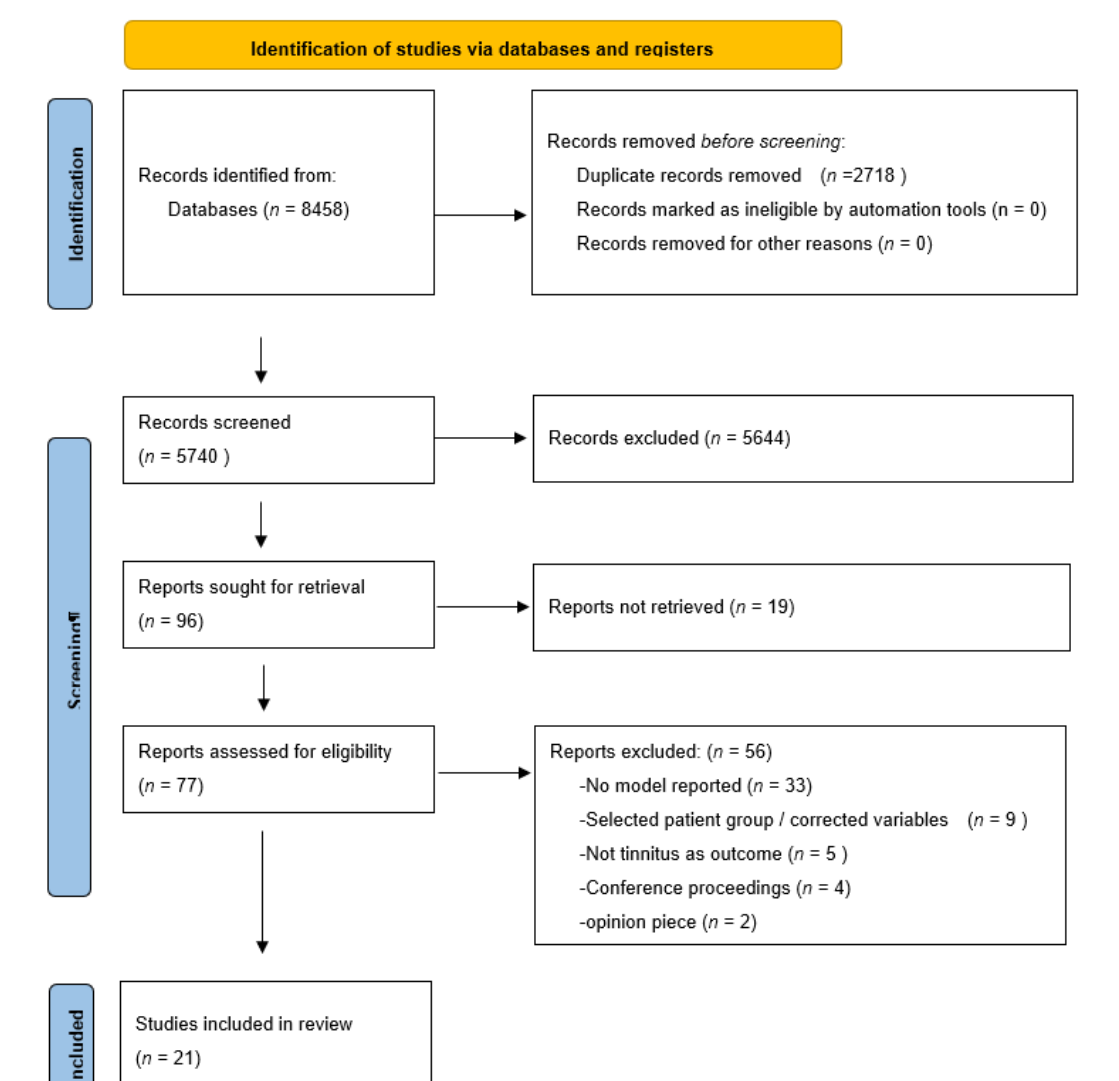
Figure 1. PRISMA flowchart.